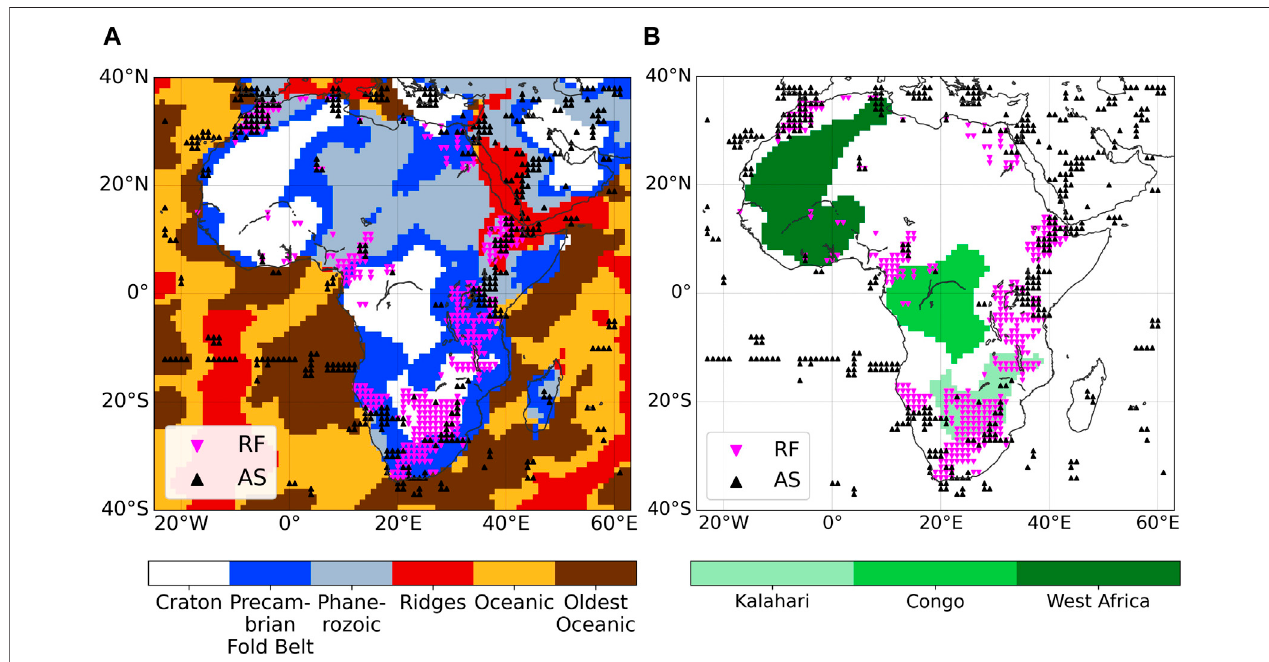
FIGURE 4 | Schematic overview on the two steps of the gravity inversion. The triangles indicate the location of AS and RF stations, respectively. (A) Step 1: Vary density contrasts of the units Precambrian, Phanerozoic, Ridges, Oceans, Oldest Oceans. Cratons are masked by white colour. (B) Step 2: Vary density contrasts of individual cratons, namely West African Craton (dark green), Congo Craton (green), Kalahari Craton (light green). Other tectonic units are masked by white colour.